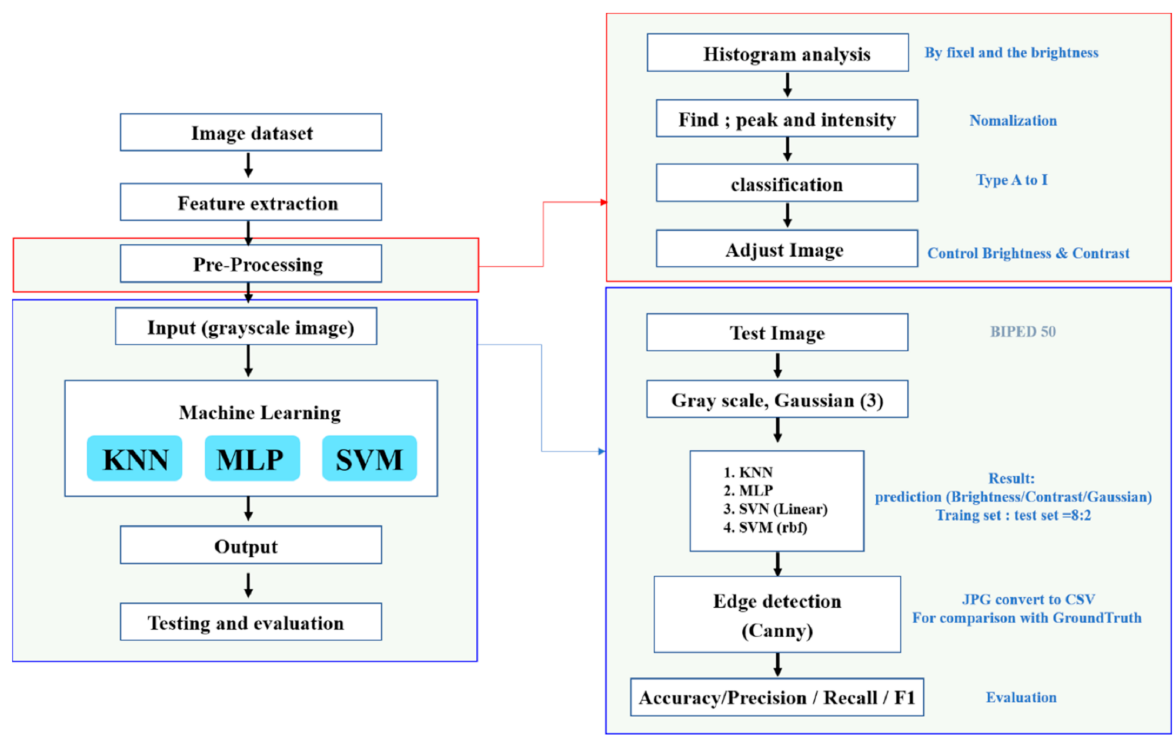
Figure 6. Proposed